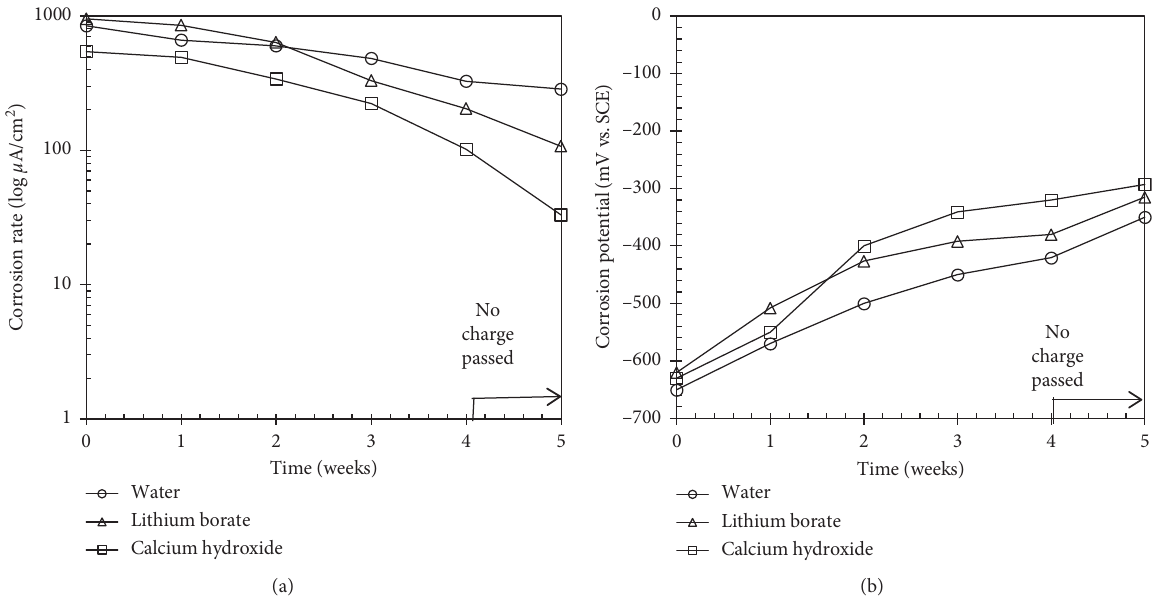
Figure 8: Corrosion values measured at each given charge passed during and after treatment ∗ in terms of (a) corrosion rate ∗∗ and (b) corrosion potential ∗∗∗ . ∗ Posttreatment values are depicted in the highlighted area of the graph to show that no current was applied in that interval; measurements were performed at 5 weeks to ensure the quality of results after depolarization time. ∗∗ (a) Corrosion rate values obtained by linear polarization at scan rate from − 20mV to +20mV versus Ecorr at 10mV/min and Stern and Geary equation. Mean values are given for each sample. ∗∗∗ (b) Corrosion potential values obtained by half-cell potential and the measurement of corrosion potential of rebar with respect to a saturated calomel electrode (SCE). Mean values are given for each sample.